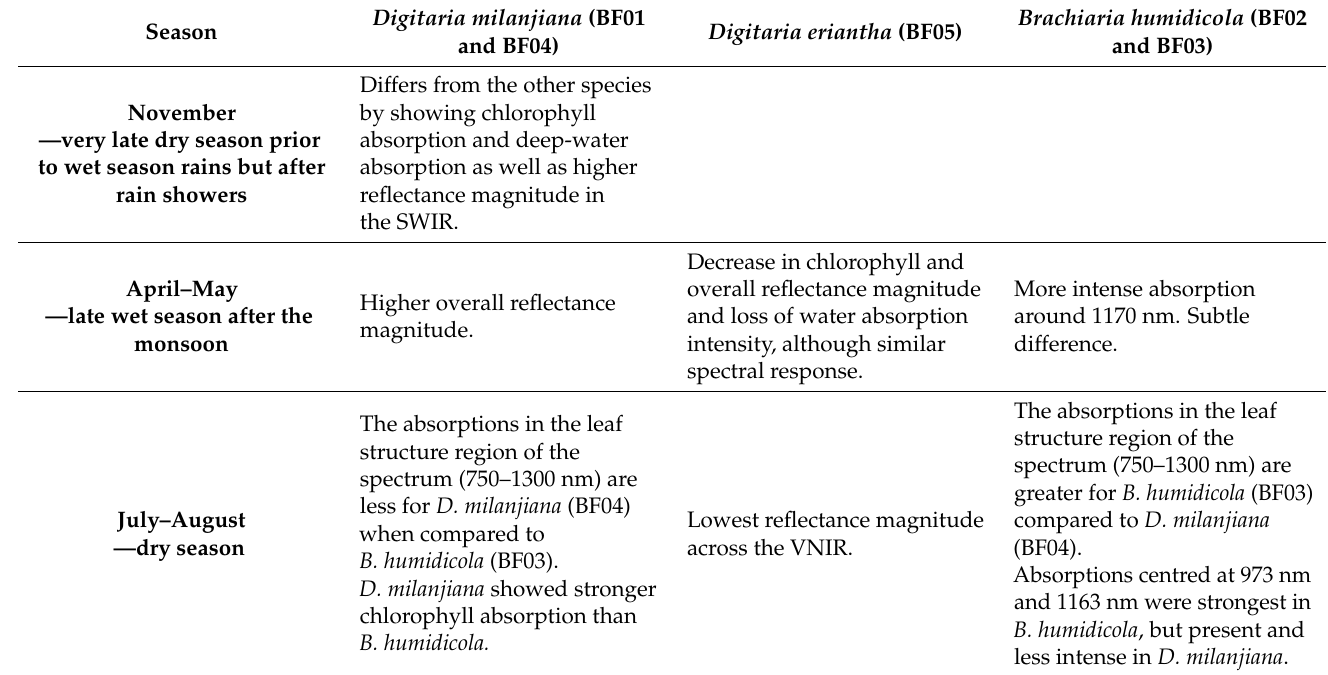
Table 2. Summary of the best timing for separability between